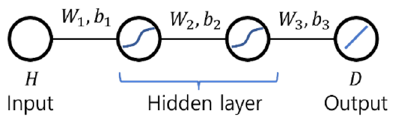
Figure 5. An output computation at a single node.